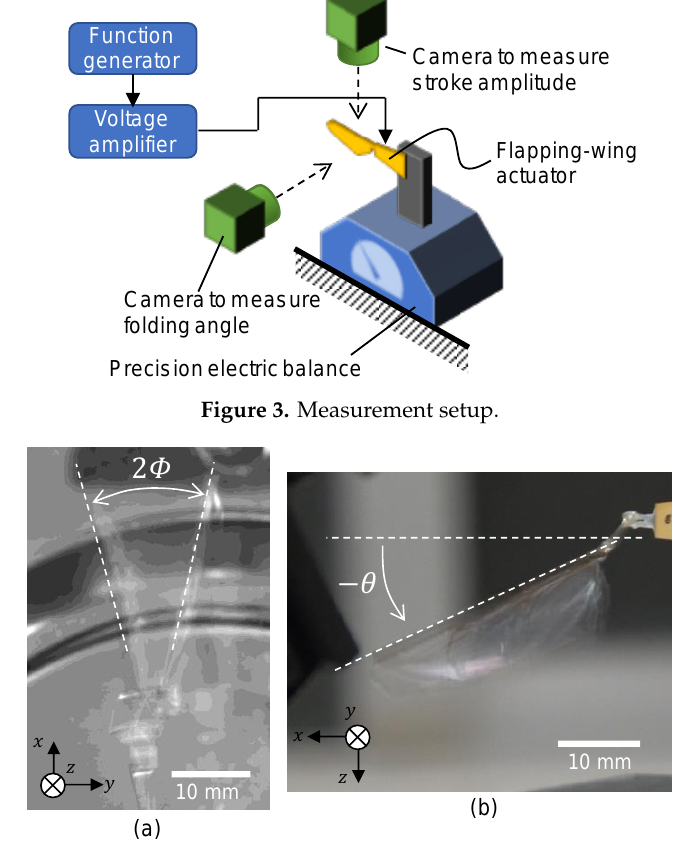
Figure 4. Typical captured image showing ( a ) stroke amplitude and ( b ) folding angle.